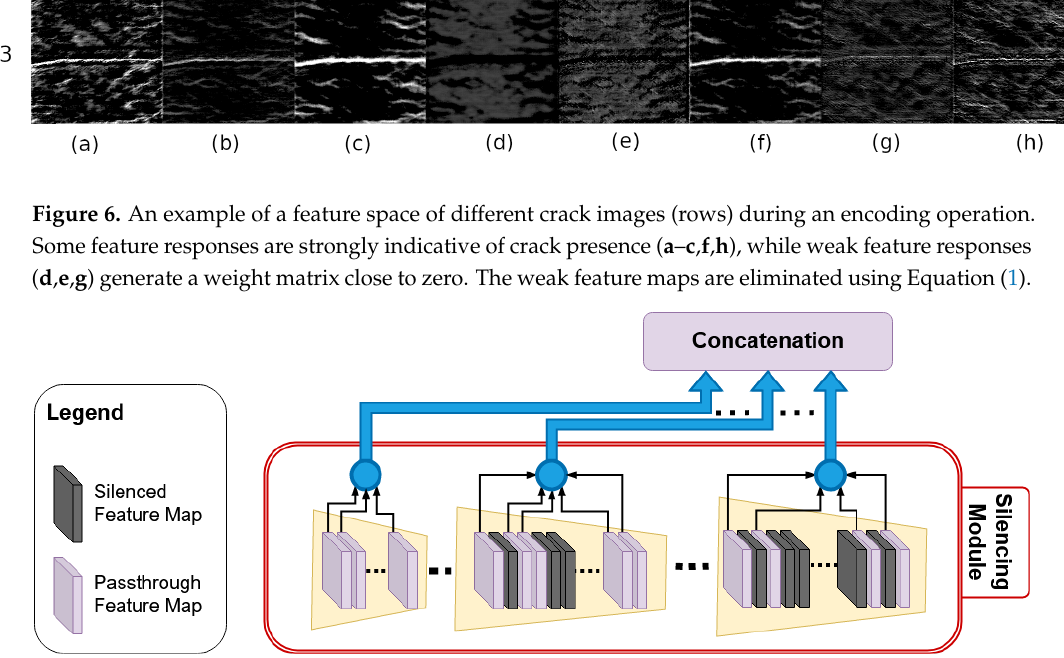
Figure 7. FSM of the proposed architecture: the silenced feature maps are represented with black